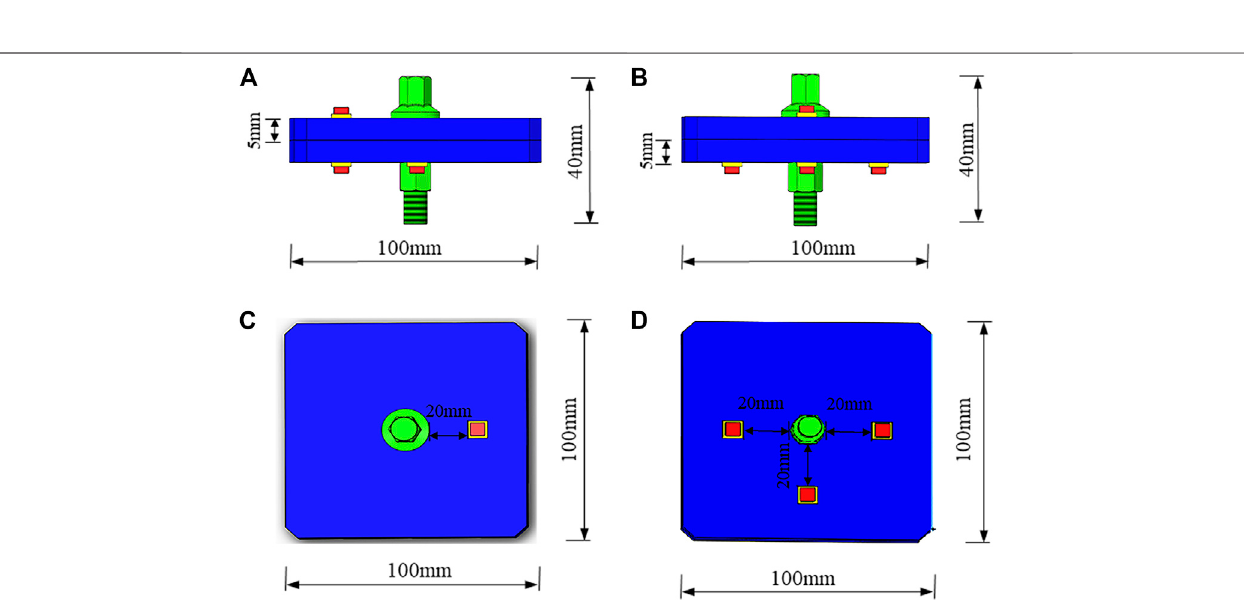
Frontiers in Materials |